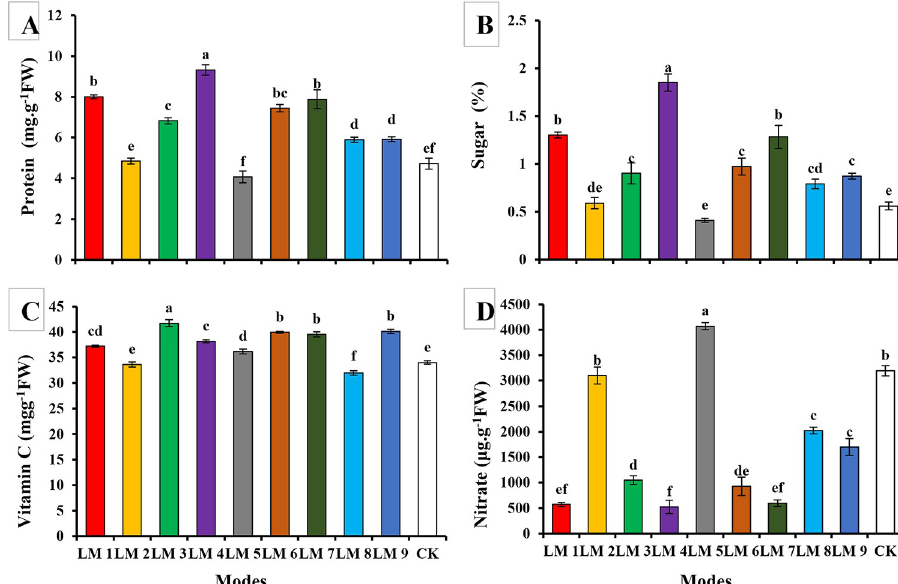
Fig 5. Effects of different lighting modes (LM) on protein (A), sugar (B), Vitamin C (C), and nitrate contents (D) in leaves of E . Sativa plants. Values are means of four replicates ± SE. Different letters between columns indicate significant differences according to Duncan’s multiple range test at P � 0.05. LM1 = A1:B1:C1, LM2 = A1:B2:C2, LM3 = A1:B3:C3, LM4 = A2:B1:C2, LM5 = A2:B2:C3, LM6 = A2:B3:C1, LM7 = A3:B1:C3, LM8 = A3:B2:C1, LM9 = A3:B3:C1, CK = White fluorescent